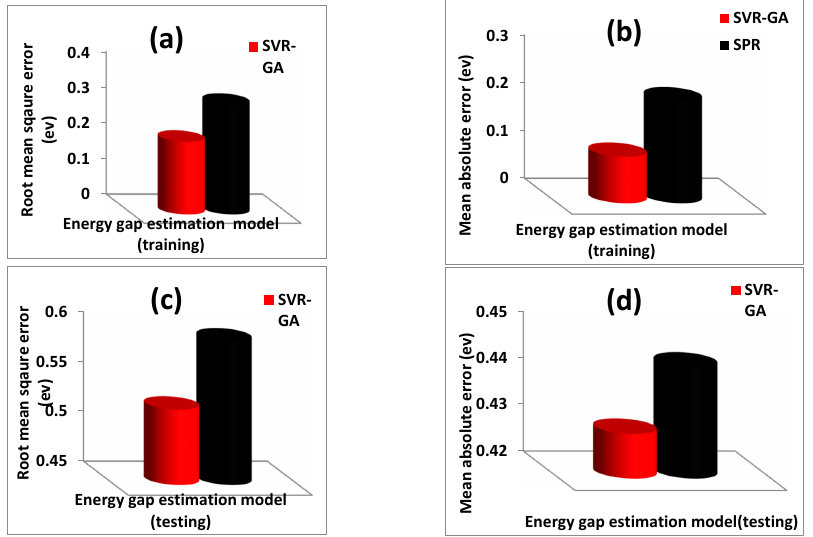
Figure 3. Performance of the developed energy gap estimation models. ( a ) Comparison of the performance of the developed SVR-GA and SPR models during training phase on the basis of RMSE, ( b ) comparison of the performance of the developed SVR-GA and SPR models during training phase on the basis of MAE, ( c ) comparison of the performance of the developed SVR-GA and SPR models during testing phase on the basis of RMSE, ( d ) comparison of the performance of the developed SVR-GA and SPR models during testing phase on the basis of MAE.